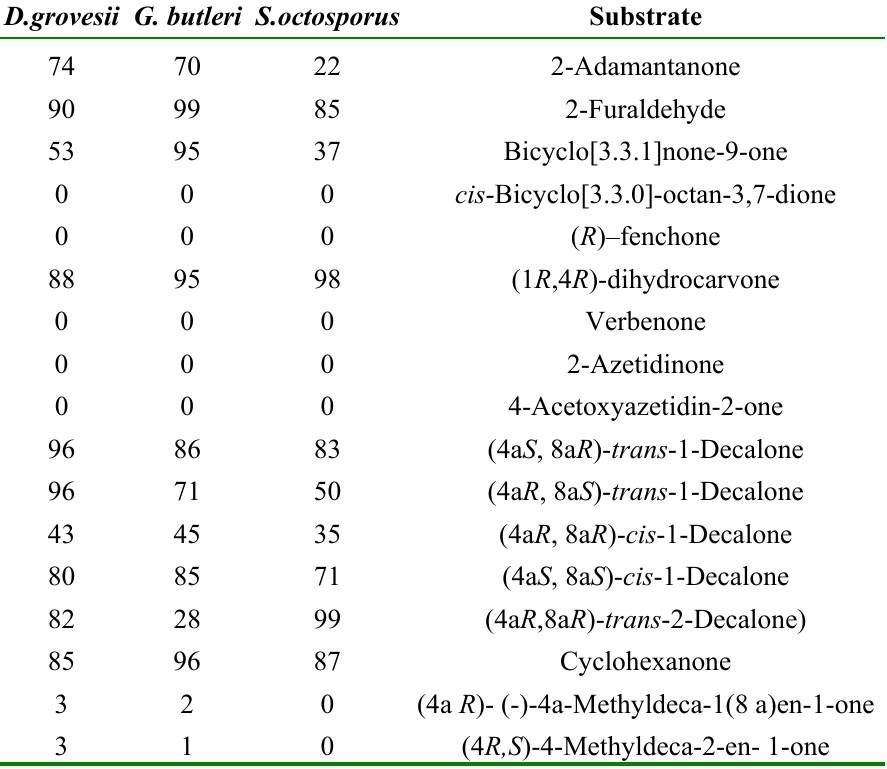
Table 7. Yields obtained in the reduction of ketones using batch fermenting conditions. T = 28ºC. [Substrate] = 2.5 mM. Reaction time = 72 h, except in the case of S. octosporus (48 h). Stirring speed =250